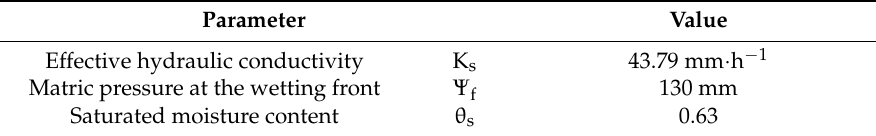
Table 1. Main soil characteristics that are available for the study area Table 1 . Main soil characteristics that are available for the study area [28].